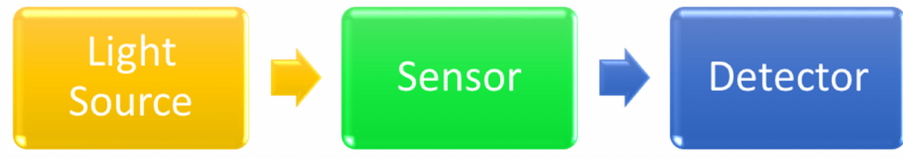
Figure 4. The basic setup of the fiber optic